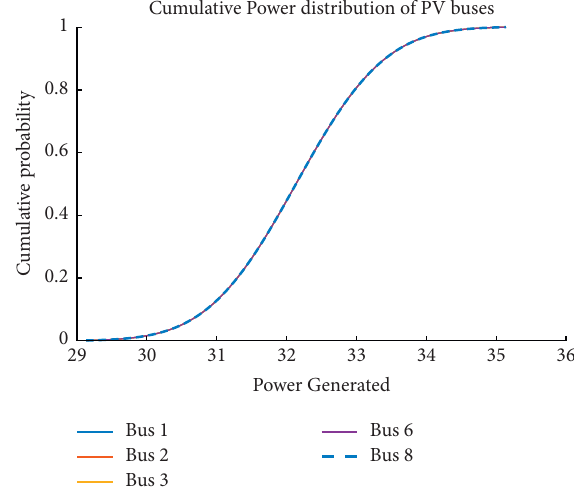
Figure 16: Power density distribution at buses 1, 2, 3, 6, and 8. Figure